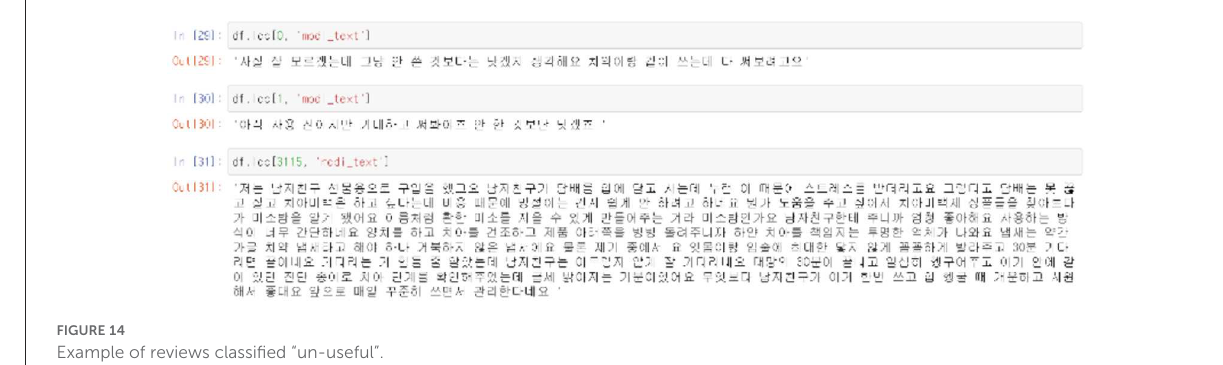
FIGURE14 Example of reviews classified “un-useful”.